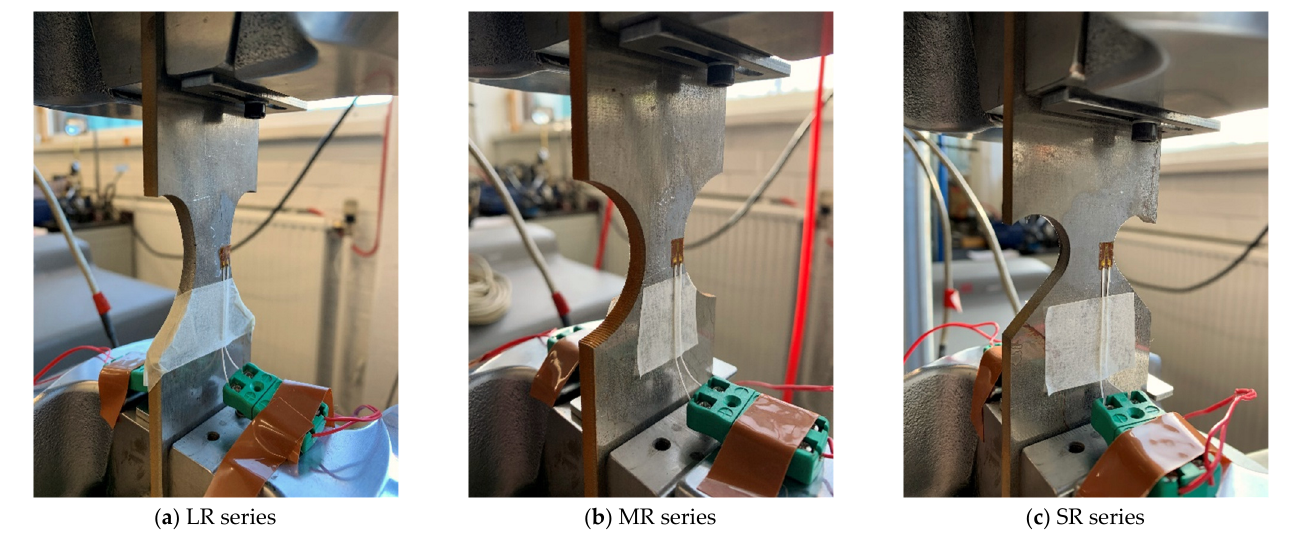
Figure 5. Setup of the fatigue test.